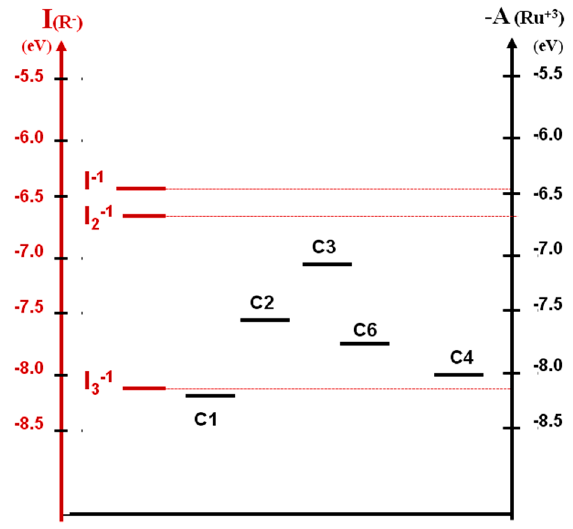
Figure 26. Ionization potential for iodide species, and electron affinity for ruthenium complexes.